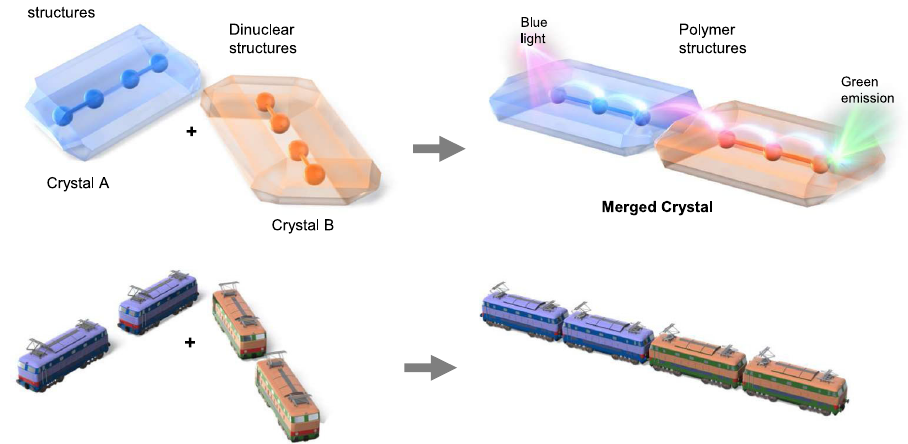
Fig. 1 Conceptual design of this work. Connection of two different emissive soft crystals, denoted molecular trains, for long-range energy migration.